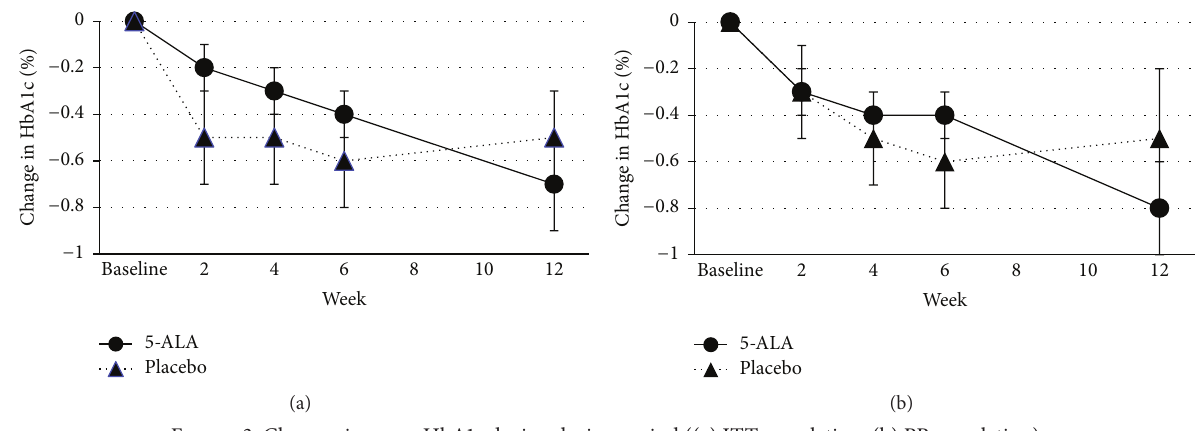
Figure 3: Changes in mean HbA1c during dosing period ((a) ITT population, (b) PP population). Table 6: Mean and change from baseline in fasting plasma glucose and plasma glucose 2 hours after breakfast (ITT population). 5-ALA-SFC Placebo Change from baseline Mean